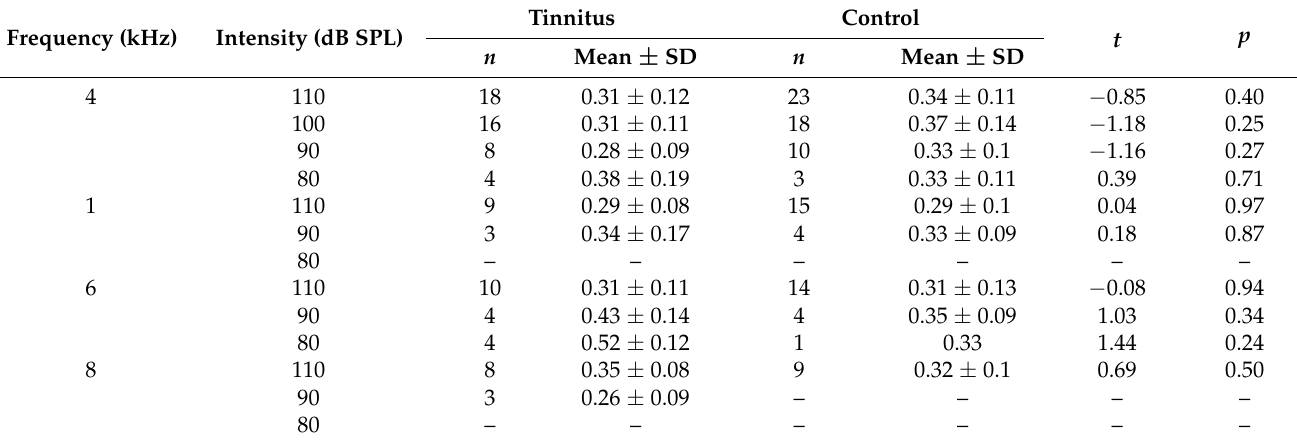
Table 6. Comparison of SP/AP ratios between the two groups.